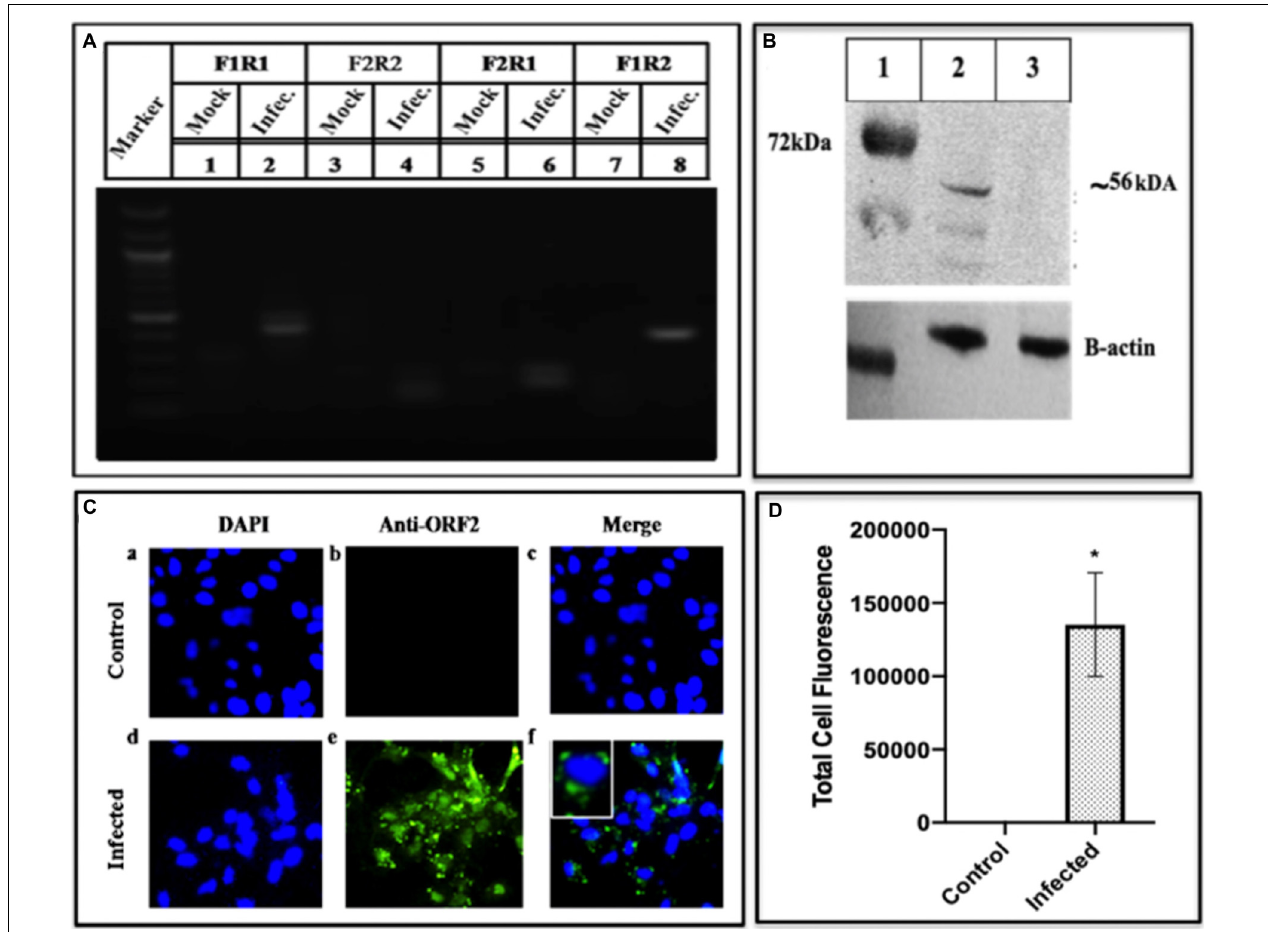
FIGURE 7 | Detection of HEV pORF2 using PCR, western blotting and immunofluorescence. (A) The HEV ORF2 gene was amplified from the cell lysate using a different set of ORF2 primers. The corresponding lanes are as follows: marker (lane M), lanes 1, 3, 5, and 7 are the negative controls while lanes 2, 4, 6, and 8 are the fragments amplified with primers from different regions of ORF2 gene as mentioned in Supplementary Table S1 . (B) Western blot of the cell lysate using epitope-specific ORF2 antibodies. The corresponding lanes are as follows: marker (lane 1), ORF2 protein from infected cells (lane 2), mock (protein from uninfected cells) (lane 3). (C) Detection of HEV pORF2 using Immunofluorescence. Cells were stained with Anti-ORF2 primary antibody detected with Alexa Fluor 488 Goat Anti-Rabbit IgG secondary antibody and counterstained with DAPI to stain nuclei. Panels (a–c) represent uninfected Huh7 cells and panels (d–f) represent HEV infected cells. Panels (c,f) represent the merged image of (a,b) and (d,f) , respectively. (D) The graph represents the mean fluorescence intensity, and the error bar indicates the standard deviation. Statistical significance of data was tested using the Mann–Whitney test ( p -value = 0.0286). * indicates p -value < 0.05. All experiments were performed at least three times as independent